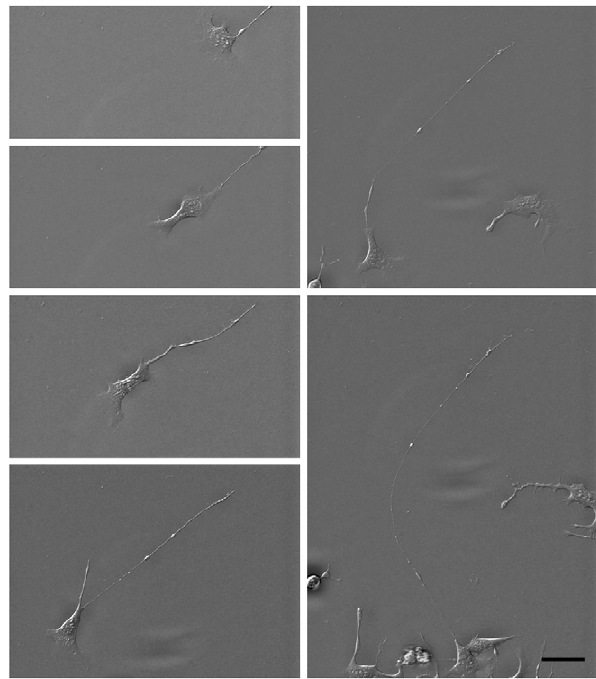
Figure 1. Time lapse acquisition of an isoquercitrin-stimulated NG108-15 cell. The images, acquired every 56 minutes, show the migration path and neurite extension out of the cell body. Note that the neurite tail undergoes a small amount of translation, where the top of each image is at the same position. The video S1 is available in the Supplementary Information. Scale bar=50